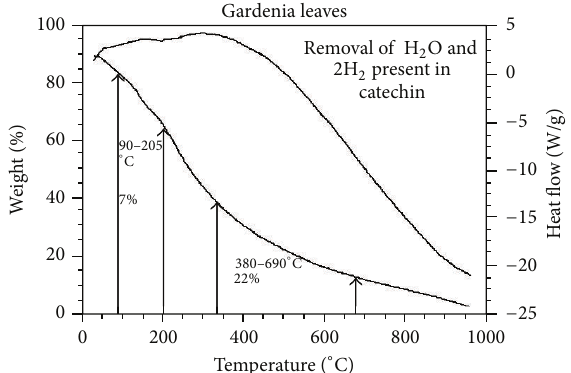
Figure 4: FTIR spectra of FeNPs synthesized using Gardenia leaves